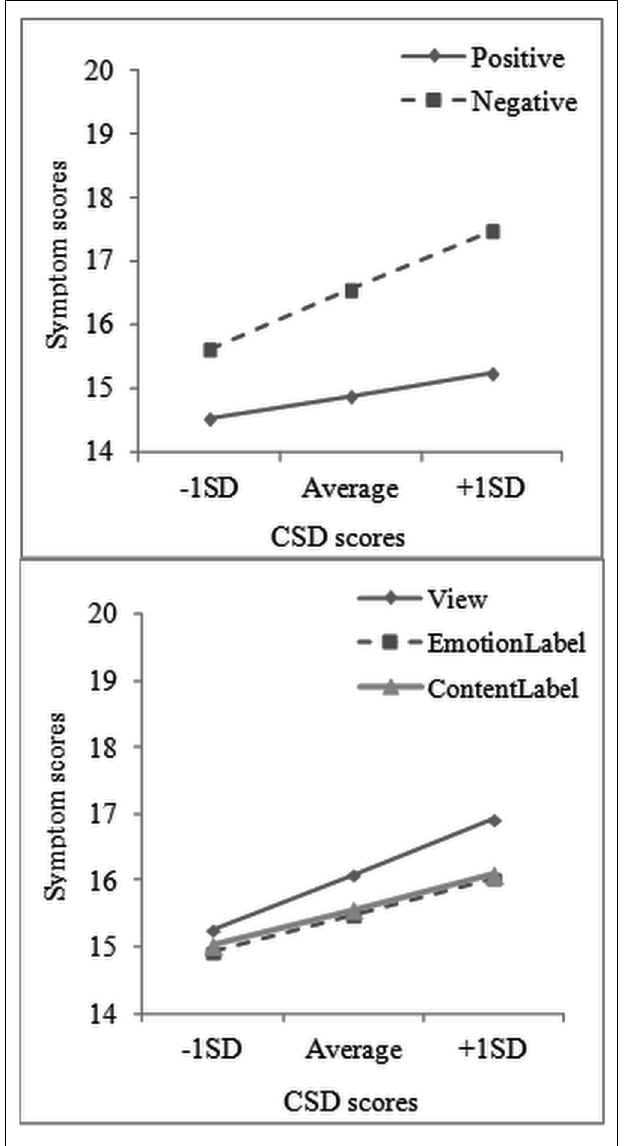
FIGURE 3 | Interaction of habitual symptom reporting scores with both Emotion (top panel) andTask (bottom panel) for symptom scores after each trial of theAffect Labeling task. CSD = Checklist for Symptoms in Daily